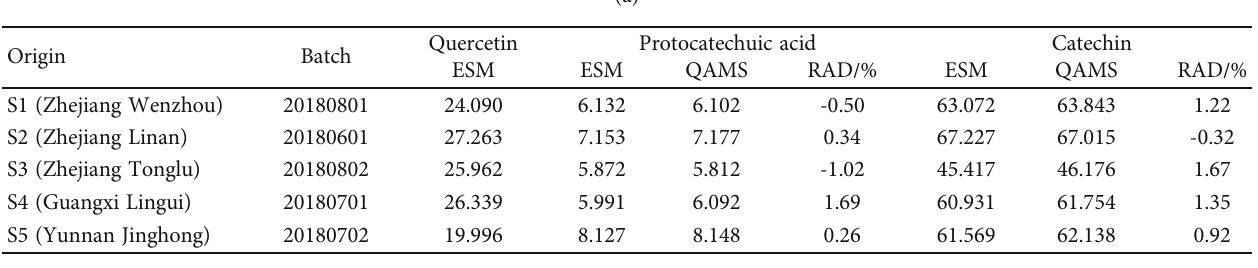
Table 1: Content of each component in Hibiscus mutabilis L of di ff erent venues ( μ g/g, n = 3 ).